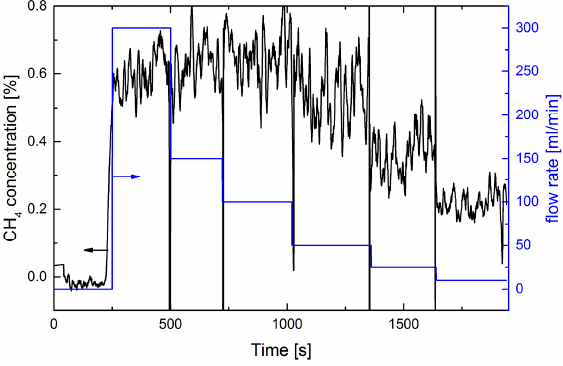
Figure 10. Static standoff measurement of 1% CH 4 in N 2 . The distance between laser and leak plate was 55 cm. The flux was stepwise reduced from 300, 150, 100, 50, 25, to 10 mL/min (blue curve, right ordinate scale).